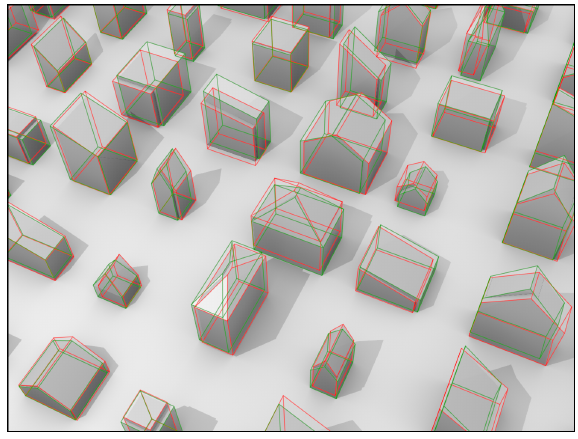
Figure 5: Visualisation of the LOD2 of the ground truth (green), and the LOD2 impaired by normally distributed positional errors with σ = 0.4 m (red model). Equal spatial extent as in Fig.